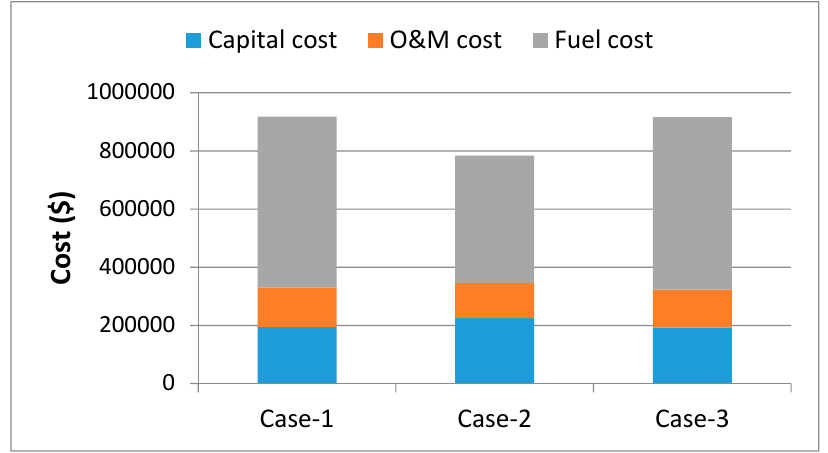
Figure 14. Cost breakdown.